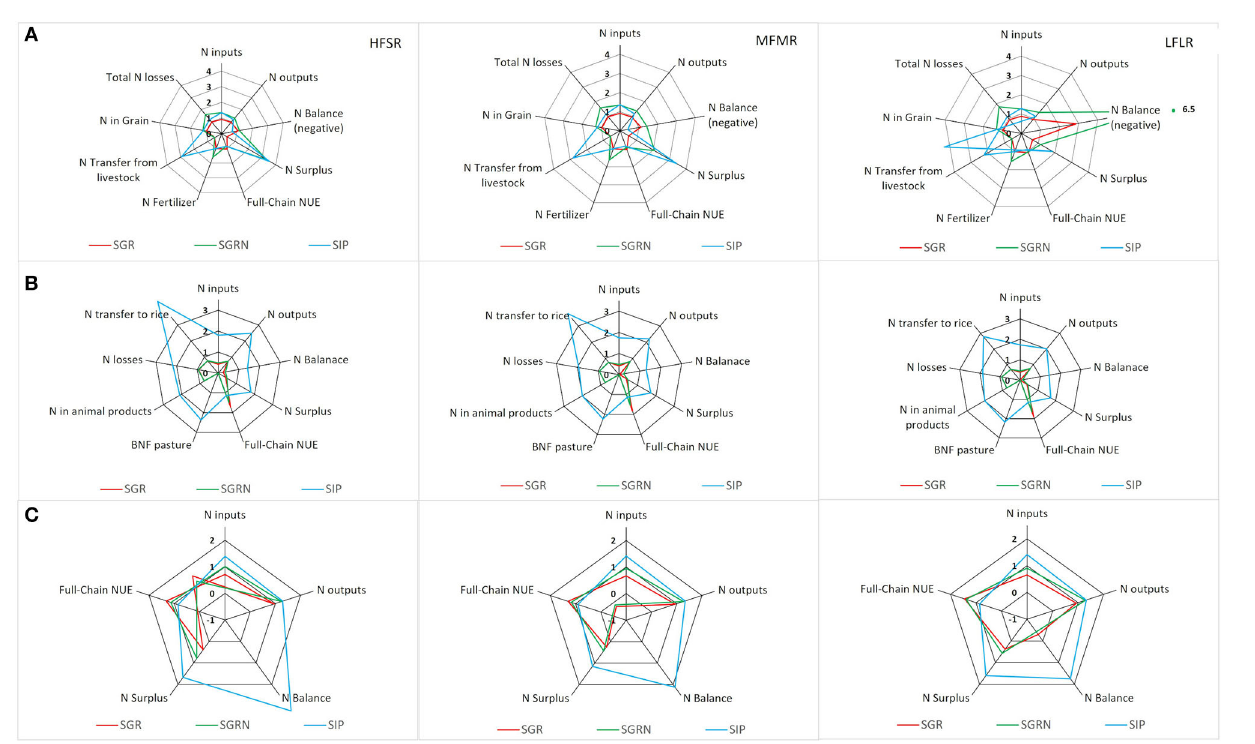
FIGURE4 Relative changes of N balance, N inputs N outputs, N surplus, and N use efficiency for three simulated scenarios. The red line represents a rice rotation with grassland (SGR), the green line represents a rice rotation with grassland but adding extra N to the rice crop (SGRN), and the blue line represents a rice rotation with improved pasture on 80% of the total forage area (SIP). (A) Rice component, (B) livestock component, and (C) the entire system. HFSR, high fertility and short rotation; MFMR, medium fertility and medium length rotation; LFLR, low to middle fertility and long